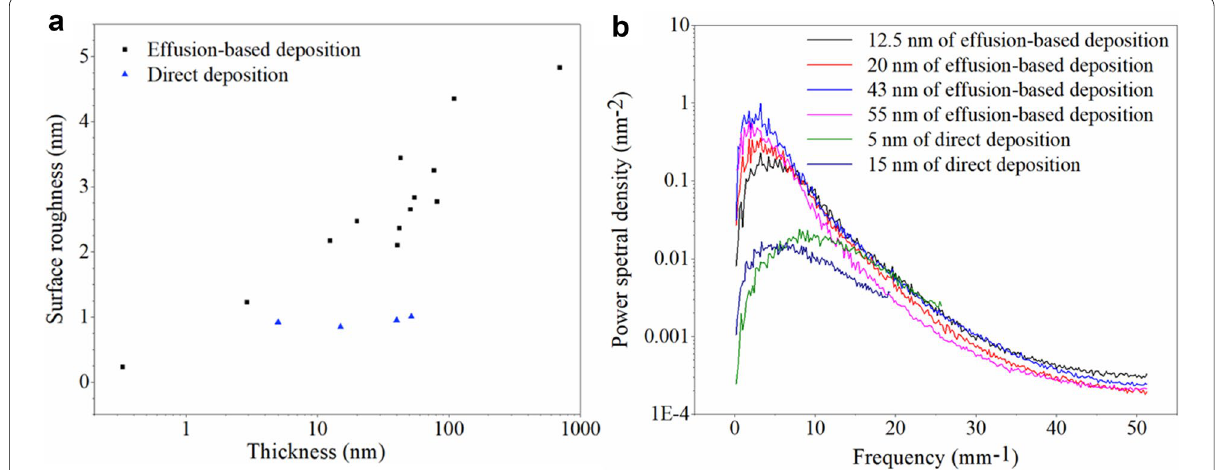
Fig. 5 Surface roughness of the direct deposition and the present effusion‑based ultra‑thin Parylene deposition measured by AFM surface scanning ( a ) and according power spectral density ( b